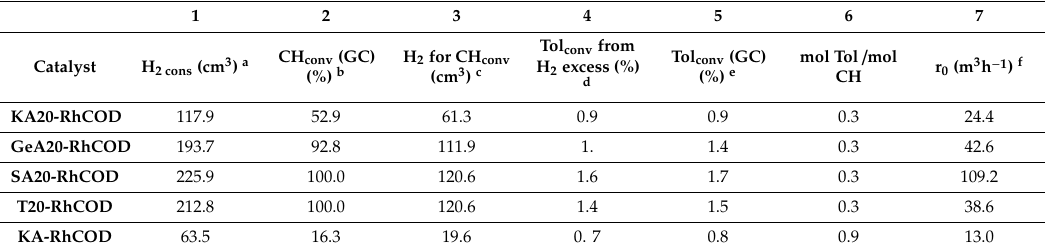
Table 2. H 2 consumption and conversion data (5% vol CH in toluene, 333 K, 10 bar H 2 , 5 h).